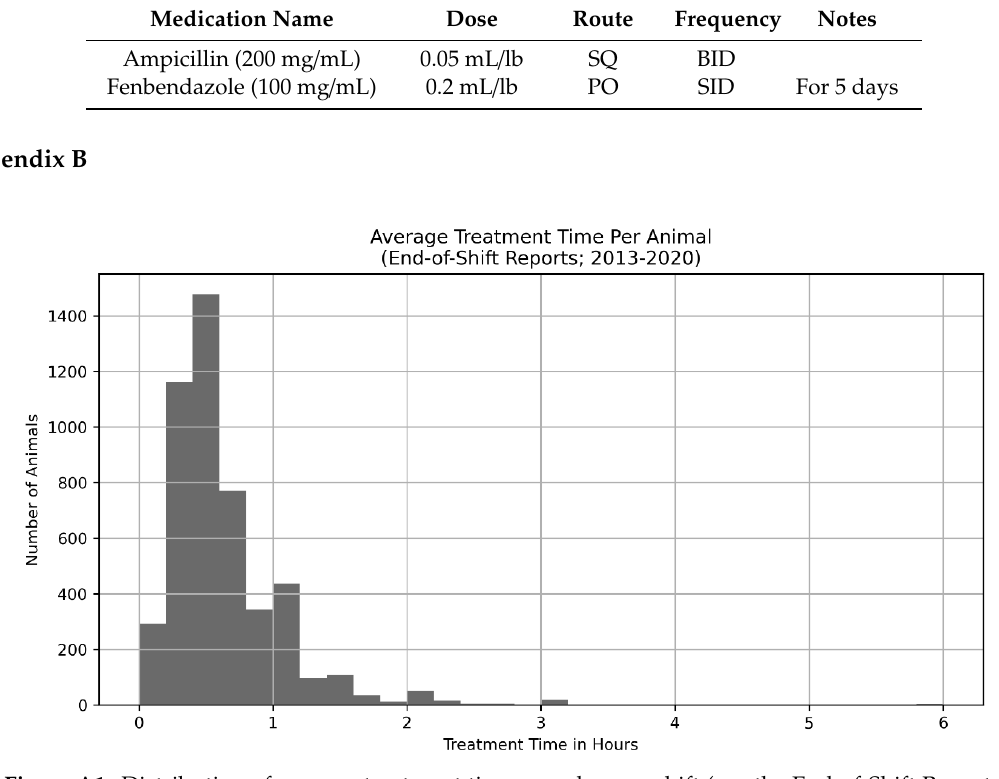
Figure B2. Distribution of length of stay of CPV-infected dogs (per the Treatment Records; N = 589; January 2017–January 2018). The length of stay was distributed around seven days. Note that the units on the horizontal axis are in treatments and there were two treatments per day. Appendix C Organizational structure and procedures are a key part of the success of a Parvo ICU. Although the complete details of operating an ICU of this sort are beyond the scope of this paper, certain key organization components are worth highlighting. Specifically, the roles of volunteers in the ICU (and their associated training), the critical supplies, including facilities, the isolation protocol, and crashing animal protocol are of critical importance to ensuring CPV infected animals can be successfully treated in mass.